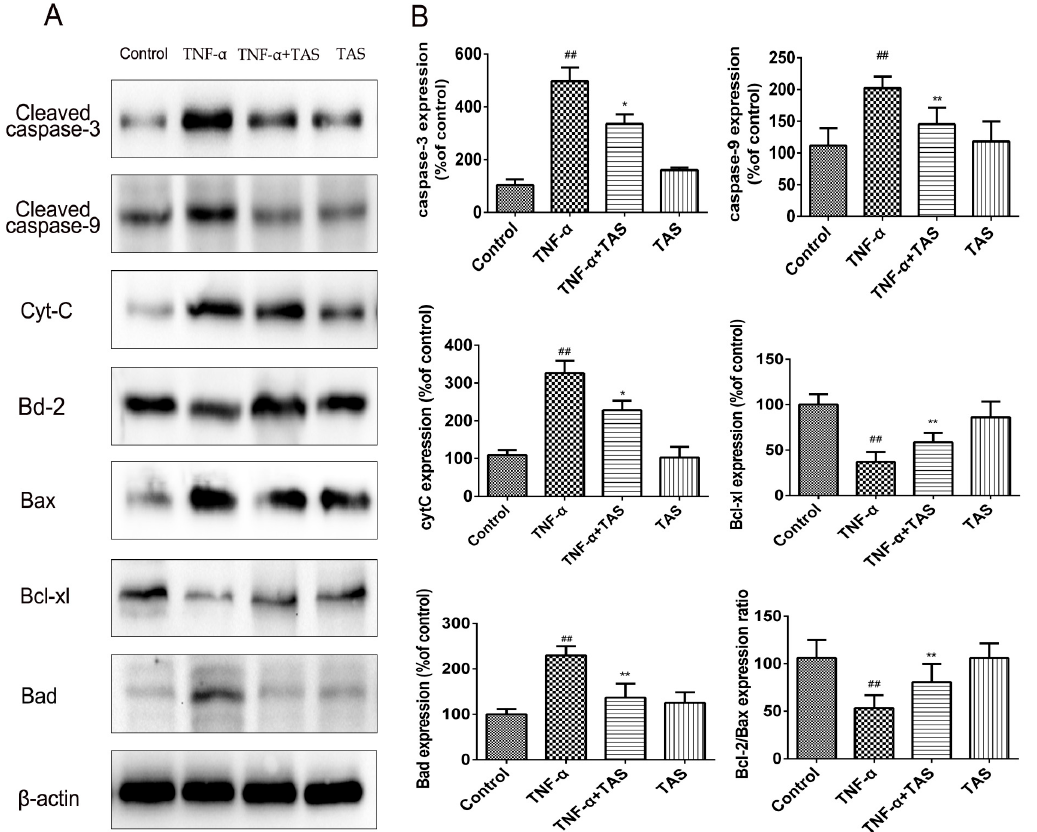
Figure 6. TAS modulated apoptosis-related proteins in HUVECs. HUVECs were preincubated with TAS (5 µ g/mL) for 2 h, followed by treatment with TNF- α (50 ng/mL) for 24 h. ( A ) The protein expression of the Bcl-2 family and caspase protein family. ( B ) Quantitative analysis of the corresponding protein expression. The data are expressed as the mean ± SD of three independent experiments. ## p < 0.01 versus the control group; * p < 0.05 and ** p < 0.01 versus the TNF- α -treatment group. The Bcl-2 protein family, including Bax, Bcl-2, Bad, and Bcl-xl, plays a pivotal role in the regulation of endotheliocyte apoptosis [24]. Our results suggested that the expression levels of the